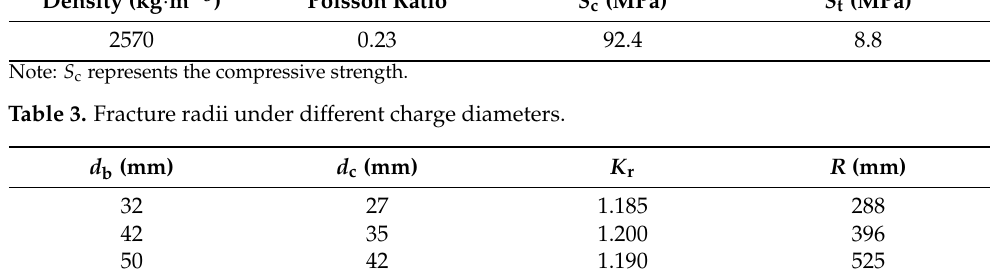
Table 3. Fracture radii under different charge diameters.